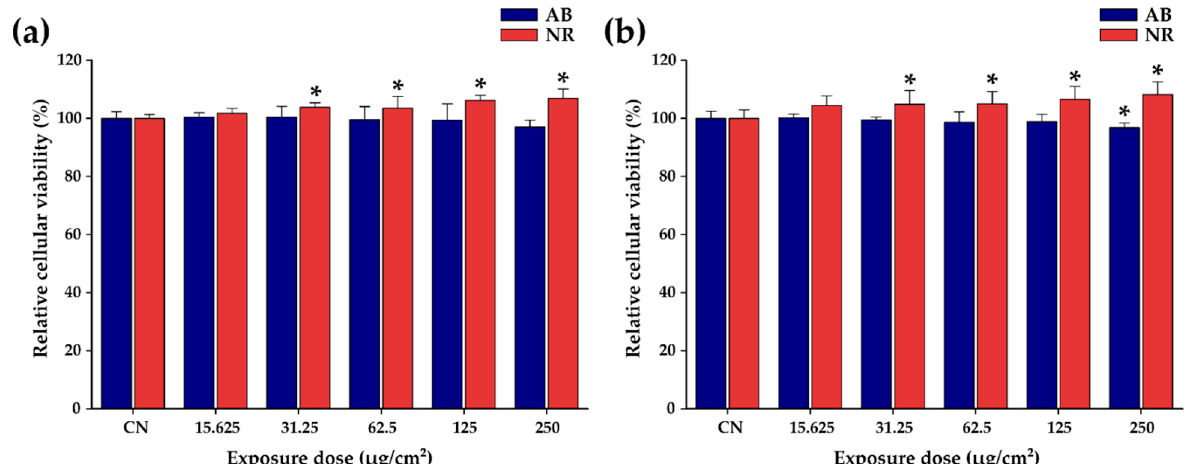
Figure 4. Cytocompatibility of ( a ) Zn ferrites and ( b ) TsMLs on A549 cell line after 48h exposure. Data are presented as relative values to the negative control (100%), as mean ± SD of three biological replicates. The significant differences compared to the negative control (ANOVA + Dunn’s; p < 0.05) are noted with asterisks (*).